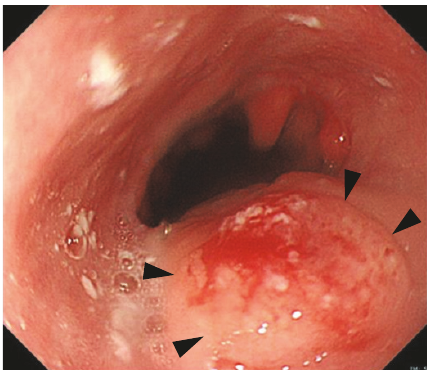
Figure 1: The gastrointestinal endoscopic finding at 16 weeks of gestation. Arrowheads indicate the recurrent lesion of esophageal cancer in the residual